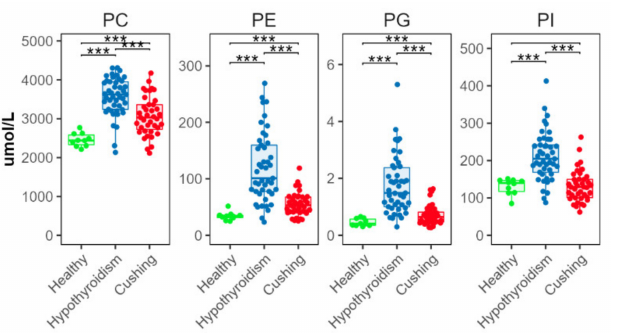
Figure 3. Total abundance of species from major diacyl phospholipid classes. Levels of statistical significance between two groups calculated by two-tailed Welch’s t -tests are indicated with stars: *** p ≤ 0.001.